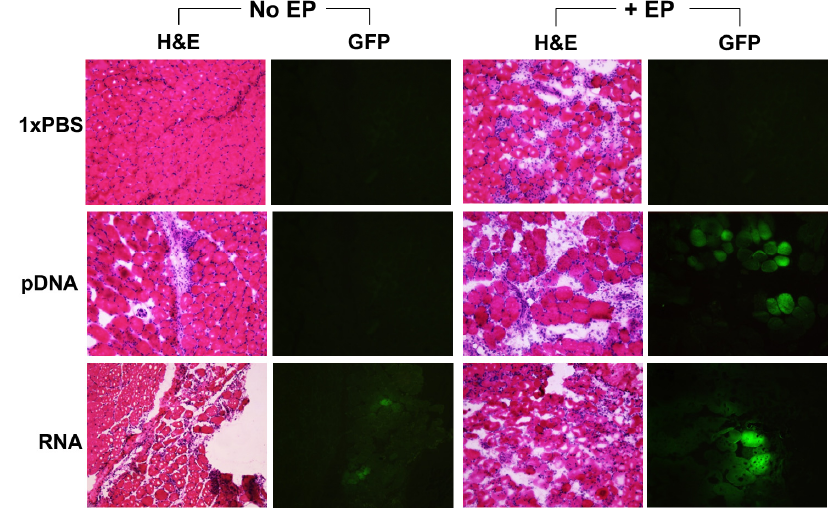
Figure 2. Histology of muscle tissues (transverse) by hematoxylin and eosin (H&E) staining, and expression of reporter protein (GFP) as delivered by intramuscular injection without EP (No EP) or with EP (+EP). Mice were injected intramuscularly with 50 µL of 1xPBS, pDNA or self-amplifying RNA vectors (pDNA or RNA, 5 µg/site). Images were obtained 2 days following treatment and are shown as representative of 6–8 slides taken per area, n = 4 muscles per